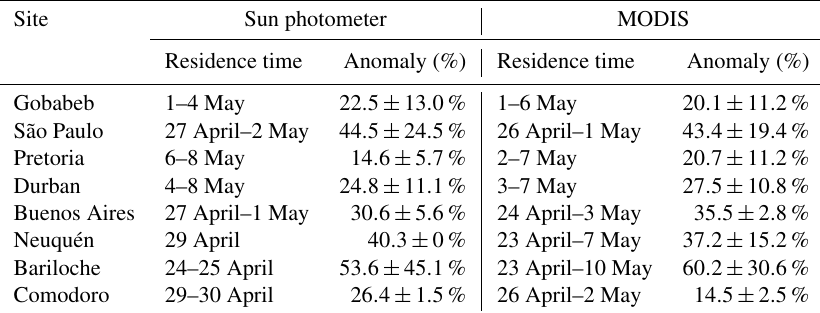
Table 2. Averaged anomaly of AOD values and the corresponding standard deviation (as a percentage) induced by the Calbuco plume during its residence over each